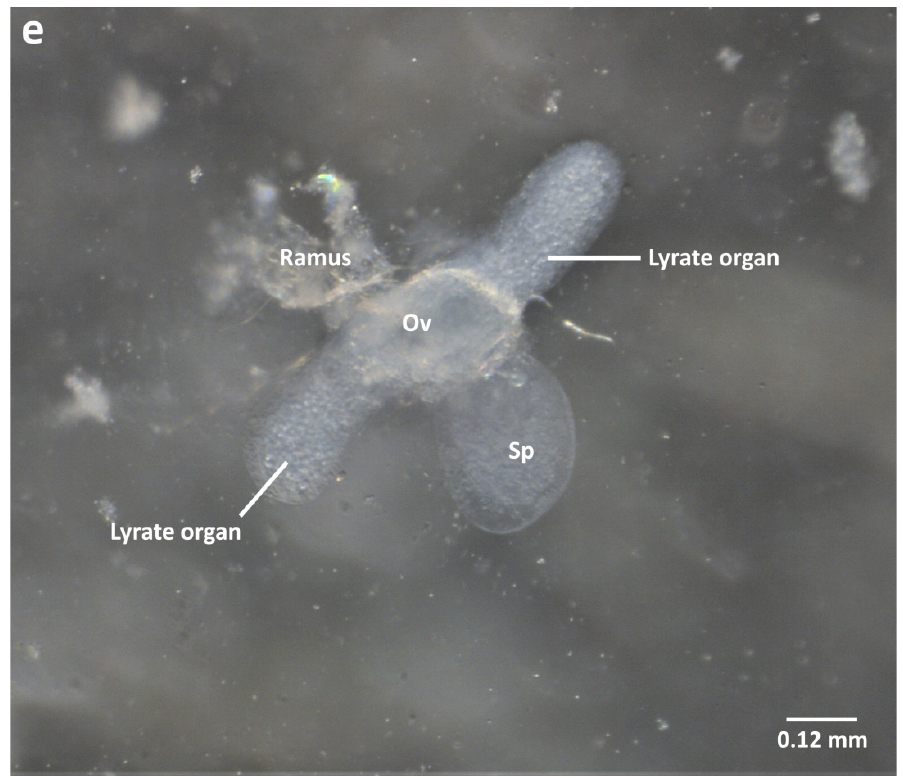
Figure 2. Pictures of the internal anatomy of reproductive V. destructor females (sampled on late- stage honey bee pupae) during ventral dissection ( a ) view after the genito-ventral scutum and the posterior metapodal scuta are removed, tracheas cover the Malpighian tubules and the caecal lobes (L), ( b ) after the layers of tracheas and fat bodies are removed, the caecal lobes (L) and Malpighian tubules (MT) are accessible ( c ) once the Malpighian tubules are extracted, the reproductive organs can be seen ( d ) after both posterior caecal lobes are extracted, the reproductive organs are now accessible ( e ) Extracted reproductive organs of a female V. destructor (L = caecal lobes; Ly = lyrate organs; Ov = ovary; MT = Malpighian tubules; Re = rectum; Sp = spermatheca; V = ventriculus).